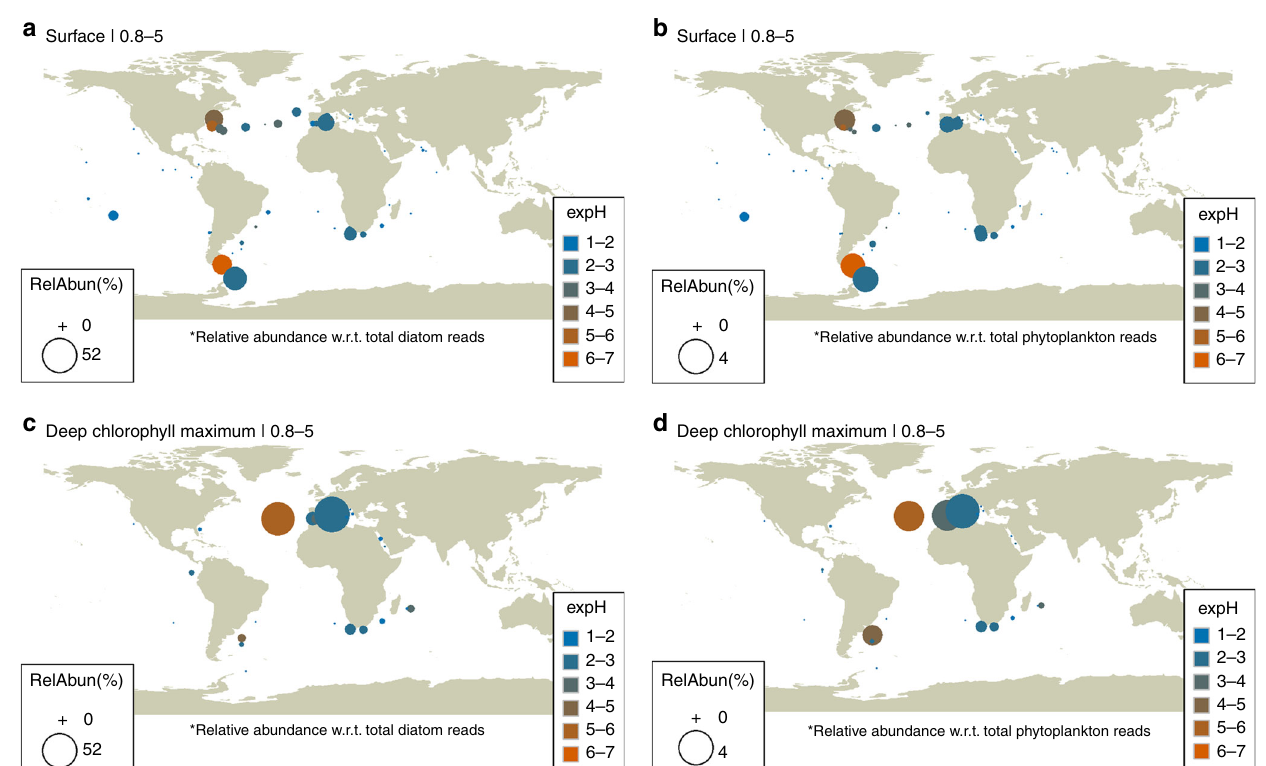
Fig. 7 Biogeographical distributions of Minidiscus from metabarcoding data. Biogeographical distributions at the surface (SRF) and deep chlorophyll maximum (DCM) depths of genus abundance and diversity of Minidiscus as relative abundance of total diatom reads ( a – c ) and as relative abundance of total phytoplankton reads ( b – d ) in the 0.8 to 5 µ m size-fractions collected during the Tara Oceans expedition (2009 – 2013) 77 . The variation in diversity for each genus is indicated as the exponentiated Shannon Diversity Index (expH) and the color represents the number of unique ribotypes (blue = low richness; orange = high richness). Bubble symbols are scaled to indicate the relative percent reads of each genus with respect to total diatoms or total photosynthetic reads in the